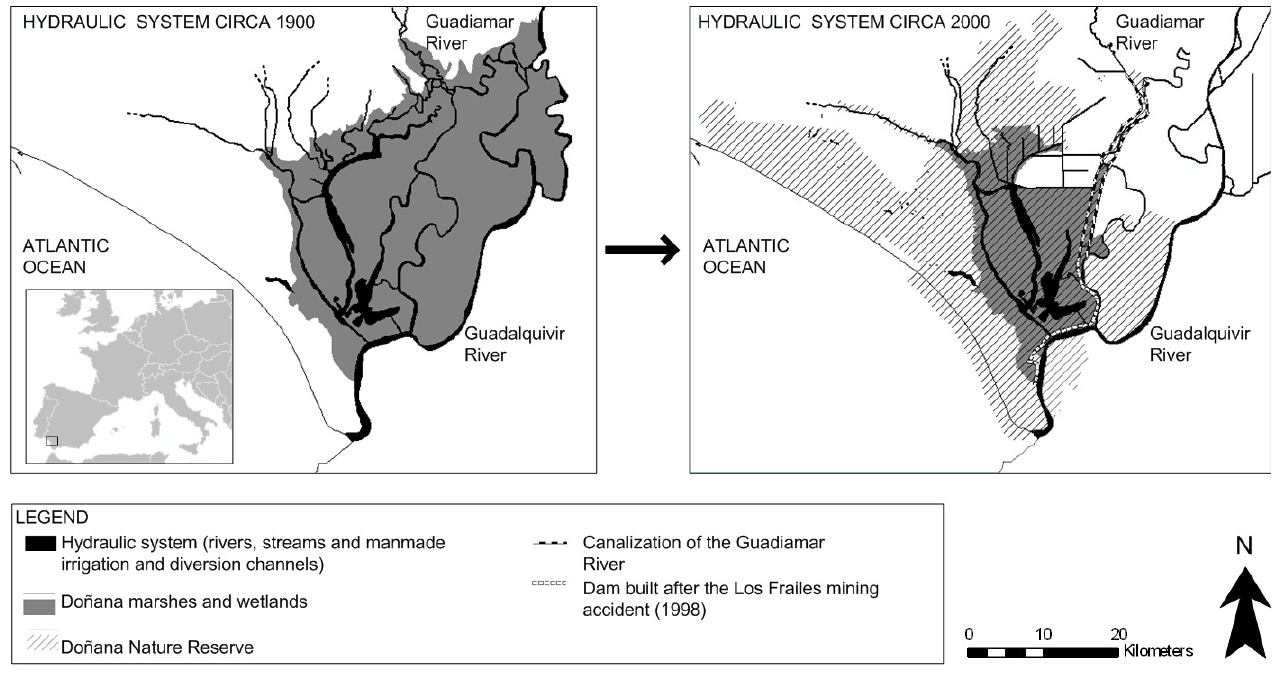
Fig. 4 . Evolution of Doñana’s hydraulic system between 1900 and